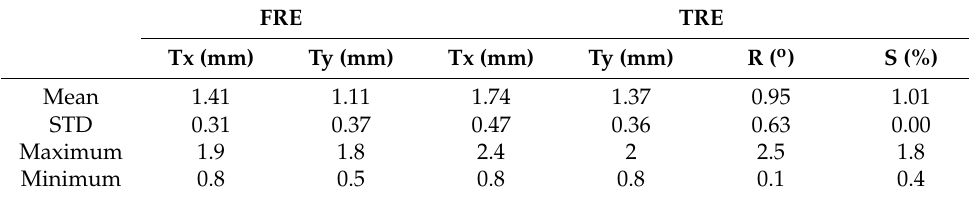
Figure 6. Registration of 3D heart model to fluorescent tissue phantom via fiducial markers as detected by the system cameras. ( A ) The initial registration experienced some initial misalignment (blue arrow) between the fluorescent target (yellow line) and the left common carotid artery (green line); ( B ) The misalignment was corrected using the stylus to select the misaligned points, causing the registration to shift and the target anatomies to become more closely aligned. Table 2. Error measurements for 3D object registration using Aruco fiducial